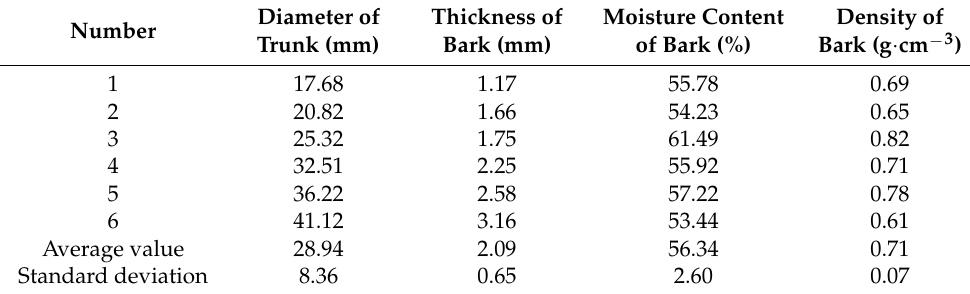
Table 1. Physical parameters of jujube